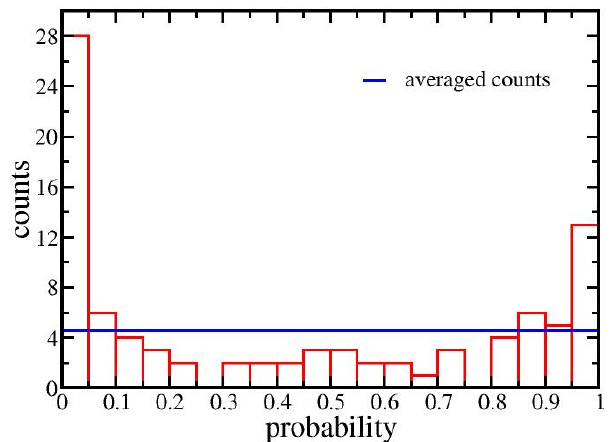
Figure 3. Histogram of P values from the WRS test for each of the miRNAs. The WRS test compared the correlations of the predicted targets with that of the non-predicted ones for each of the 91 miRNAs. As the correlation went from negative to positive the percentage of predicted target pairs decreased. Interestingly, some highly positively correlated miRNAs had high P values, which suggests an indirect relationship with the predicted target.